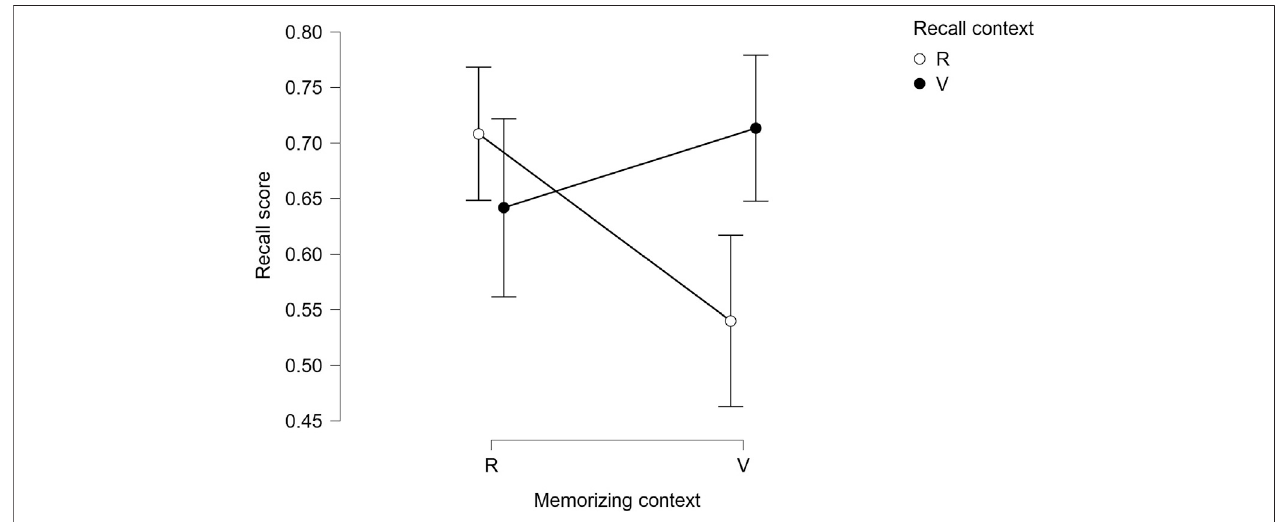
FIGURE 5 | Plot of mean recall scores with 95% con fi dence intervals for four different combinations of memorizing and recallcontexts. Crossing of the connecting lines illustrates potential interaction of the memorizing and recall contexts on the recall score (detailed values in Table 4 ).